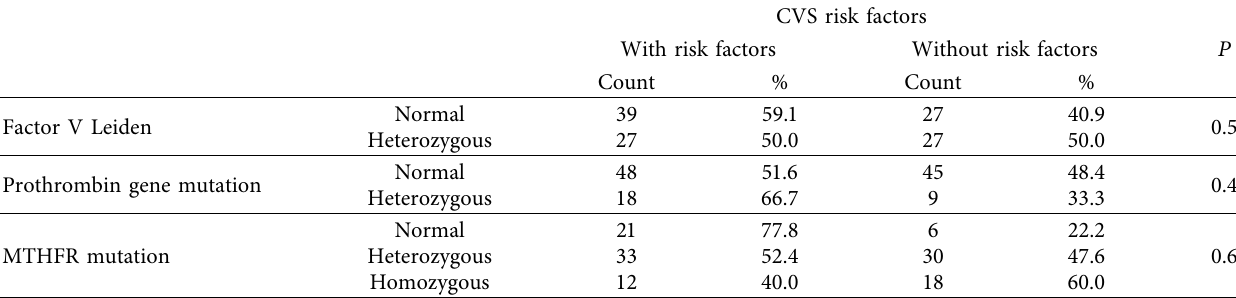
Table 5: Percentage of factor V Leiden, prothrombin gene, and MTHFR mutations in patients with cardiovascular risk factors versus the patients with noncardiovascular risk factors